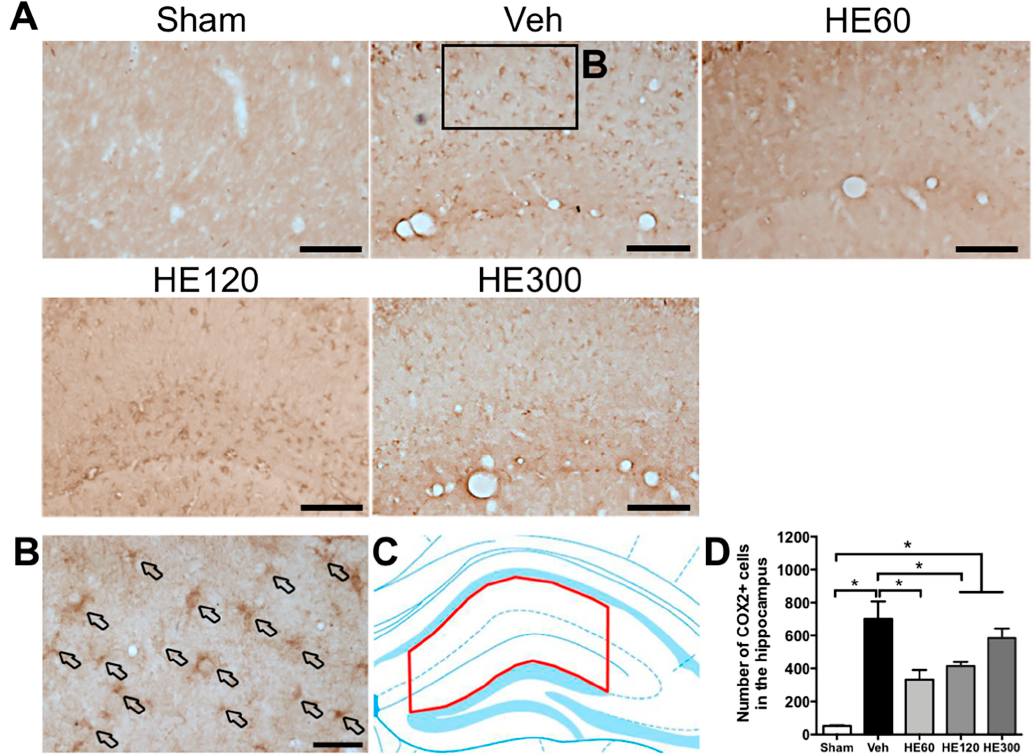
Figure 4. HE administration at 60 and 120 mg/kg reduced the number of cyclooxygenase 2 (COX2)-expressing cells in the hippocampus after pilocarpine-induced SE. ( A ) Representative photomicrographs showing immunohistochemistry to COX2 in sham, vehicle (Veh)-, 60 mg/kg HE- (HE60), 120 mg/kg HE- (HE120), and 300 mg/kg HE-treated groups (HE300). Scale bar: 100 µ m. ( B ) A magnified photomicrograph showing COX2-expressing cells in the region marked as a rectangle in Veh-treated group. Arrows indicate various COX2-expressing cells in the hippocampus. Scale bar: 20 µ m. ( C ) A drawing of the hippocampus indicating the region for the quantitative analysis of COX2 expression (shown in red). ( D ) A graph showing the number of COX2-expressing cells in the hippocampus. Note that SE induced marked upregulation of COX2-expressing cells shown in Veh-treated group. HE administration at 60 and 120 mg/kg led to significantly fewer COX2-positive cells in the hippocampus than the Veh-treated group, whereas 300 mg/kg HE treatment resulted in similar COX2 activation compared to the Veh-treated group. Data are shown as mean ± SEM. n = 7 (sham), n = 9 (Veh), n = 8 (HE60), n = 7 (HE120), n = 6 (HE300). * p < 0.05; one-way ANOVA with Tukey’s post-hoc test.